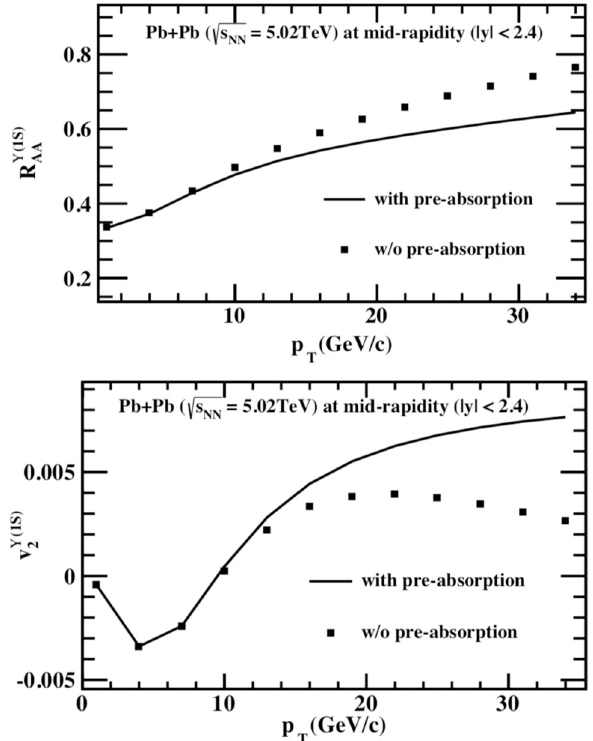
Fig. 5 The impact of pre-resonance absorption on the p T dependence of R AA (top) and v 2 (bottom) of the inclusive ϒ( 1 S )